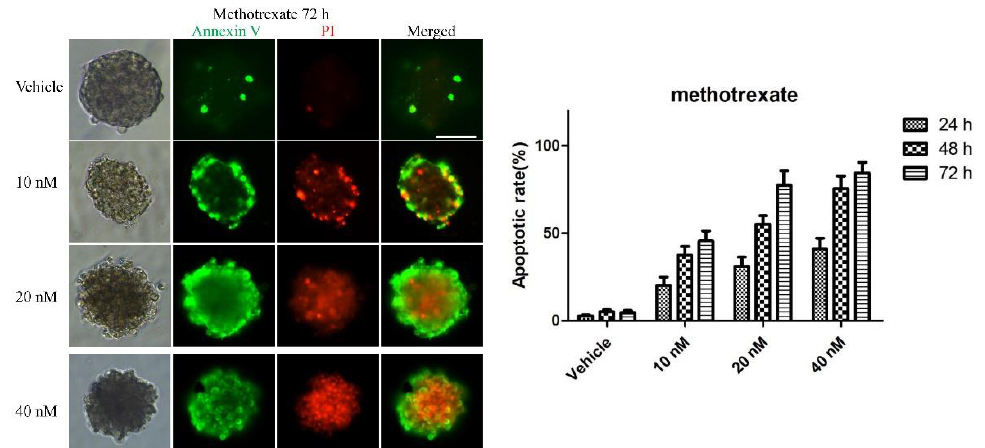
Figure 8. Immunofluorescence analysis of apoptotic marker (Annexin V, green) and necrotic marker (PI, red) after drug (methotrexate) treatment in the 3D spheroid models. The fraction of the apoptotic and necrotic cells appeared to be correlated with the concentration and time. The histogram shows the apoptosis rate at the indicated concentrations after 24 h, 48 h and 72 h of the methotrexate administration (the data are presented as mean ± SD). Magnification = 20×, Bar = 75 µm.